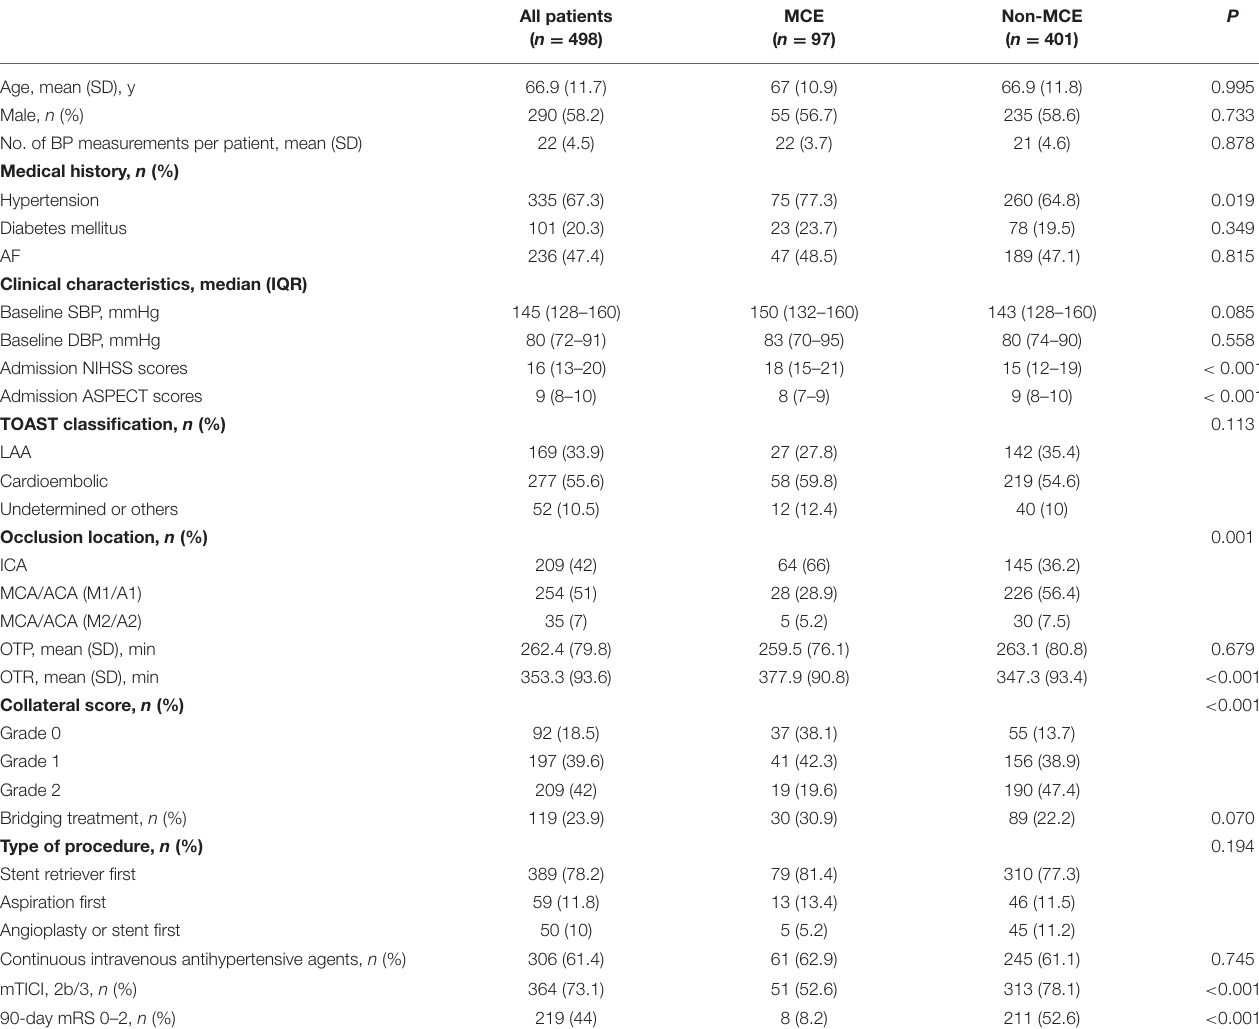
TABLE 1 | Demographics and baseline characteristics stratified by MCE.